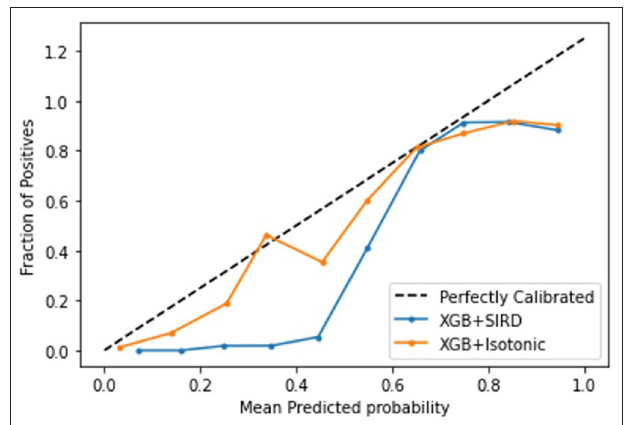
FIGURE 7 | XG Boost classifier calibration graph for class 0.